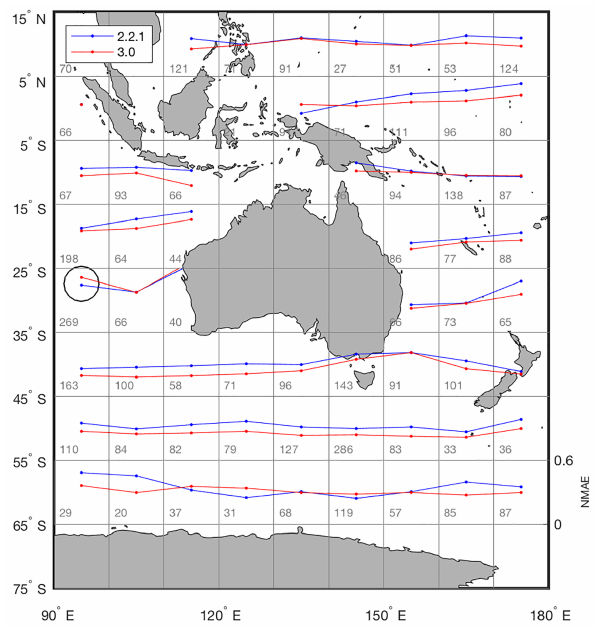
Figure 5. The NMAE for OceanMAPS versions 2.2.1 (blue) and 3.0 (red), averaged over 10 ◦ × 10 ◦ latitude and longitude bins. Each plot is scaled over 0–0.6. The number of profiles within each bin is indicated by the grey text. The area where version 2.2.1 performs better than version 3.0 discussed in Sect. 4.2 is circled.